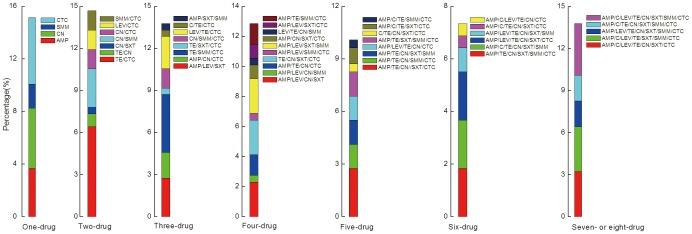
Percentage of E. coli number in each antibiotic-resistance pattern accounting for the total E. coli isolates from the Jiyun River.TE, tetracycline; CTC, chlortetracycline; SXT, sulfamethoxazole-trimethoprim; SMM, sulfamonomethoxine; AMP, ampicillin; C, chloromycetin; LEV, levofloxacin; CN, gentamycin.